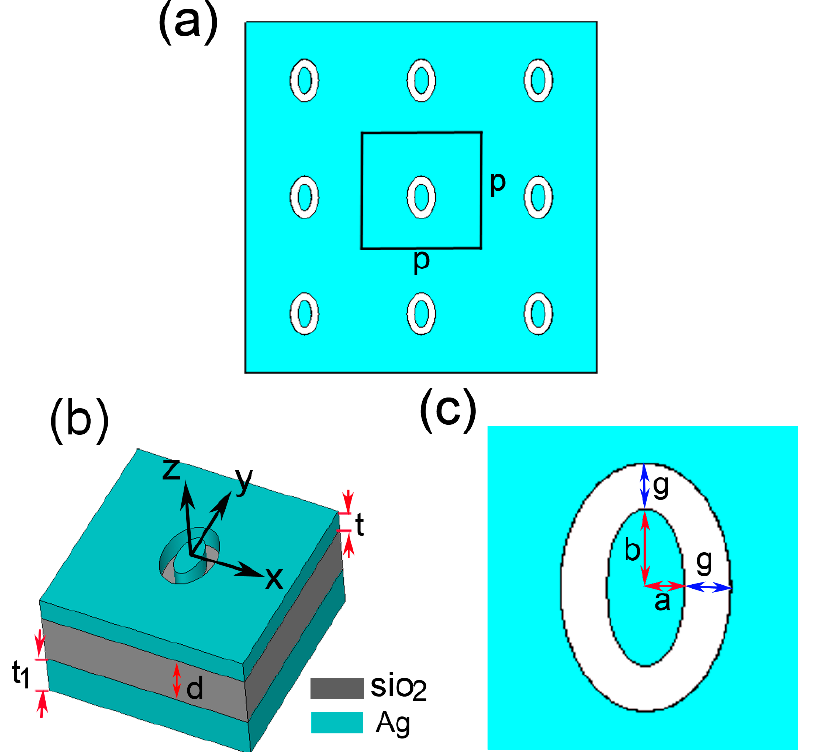
Figure 1. ( a ) Schematic diagram of periodic elliptical nano-slits. ( b ) A perspective view of the unit cell with Ag-Sio 2 -Ag configuration. ( c ) A front view of a single elliptical nano-slit with a = 43 nm, b = 86 nm, g = 50